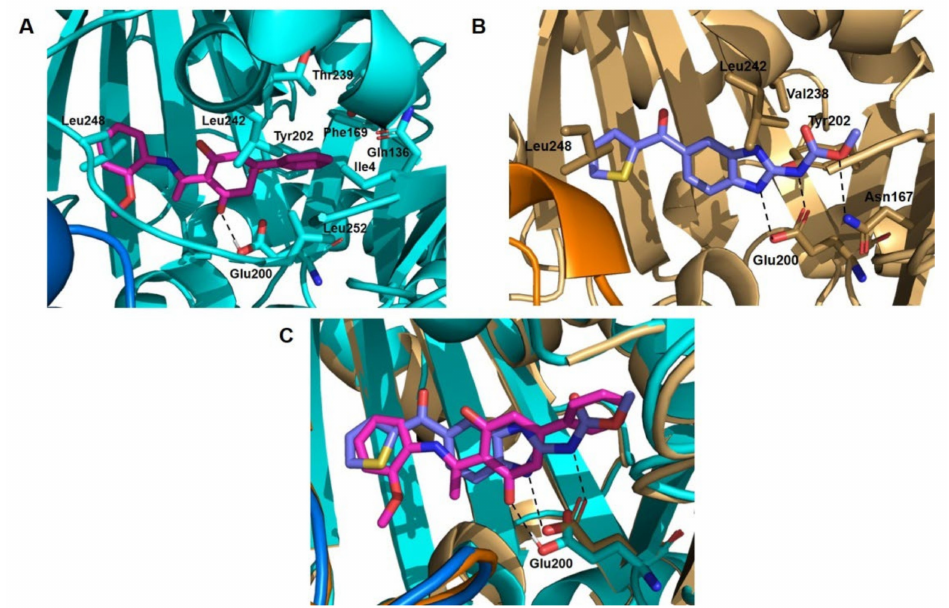
Figure 2. ( A ) X-ray complex structure of TUB015 ( 4 , magenta sticks) in tubulin ( α -tubulin shown in blue marine and β -tubulin in cyan). ( B ) X-ray complex structure of nocodazole ( 5 , violet sticks) in tubulin ( α -tubulin is shown in orange and β -tubulin in light orange). ( C ) Superimposition of X-ray structures of TUB015 ( 4 ) and nocodazole ( 5 ). Selected residues of the binding pocket are shown in sticks and labeled. Dashed lines represent hydrogen